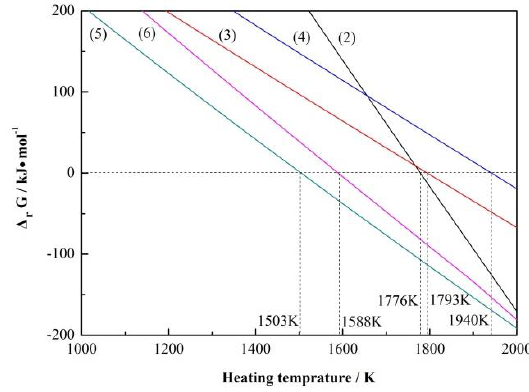
Figure 1. Gibbs free energies ( ∆ r G ) of Reactions (2)–(6) at di ff erent temperatures.